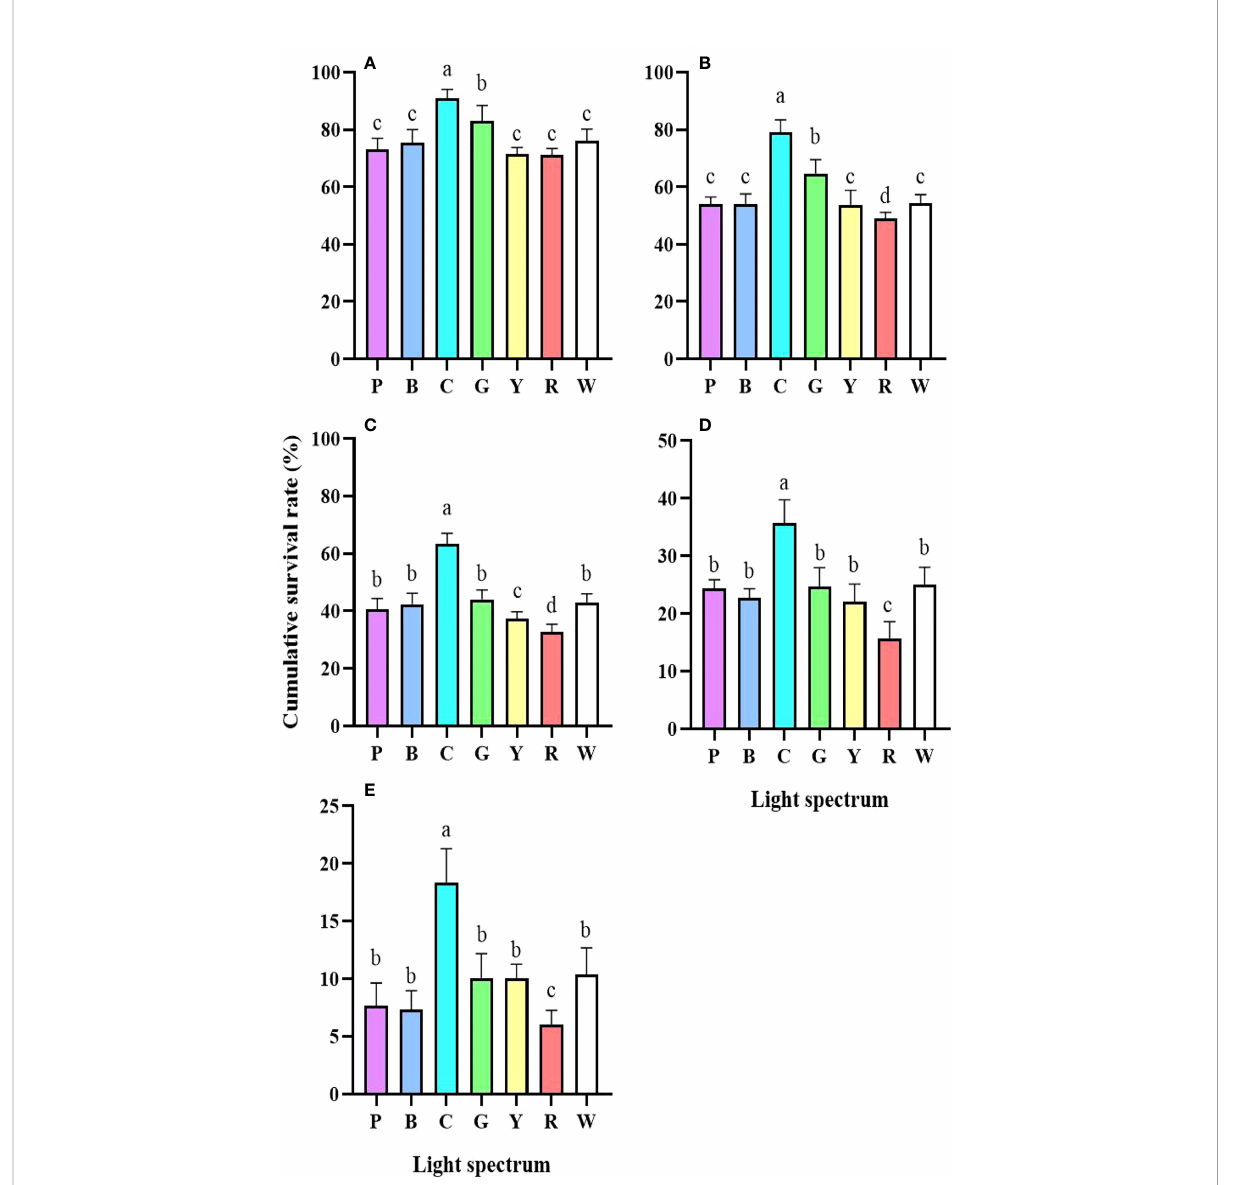
FIGURE 1 Cumulative survival rate of P. trituberculatus larvae under different light spectrum (mean ± SD) (n=6). (A) Zoea I, (B) Zoea II, (C) Zoea III, (D) Zoea IV, (E) Megalopa. P, Purple; B, Blue; C, Cyan; G, Green; Y, Yellow; R, Red; W, White. Different letters indicate signi fi cant differences between treatment groups ( P